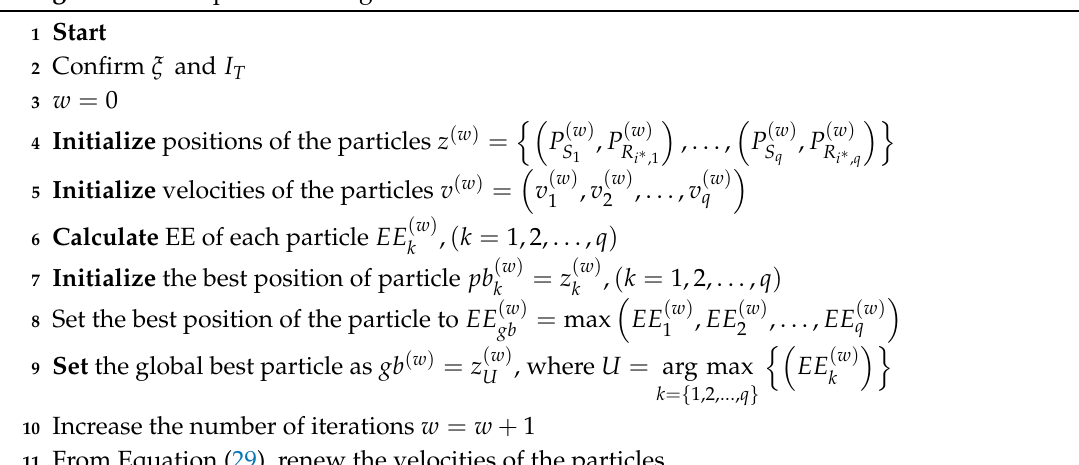
Algorithm 1: Proposed PSO algorithm for